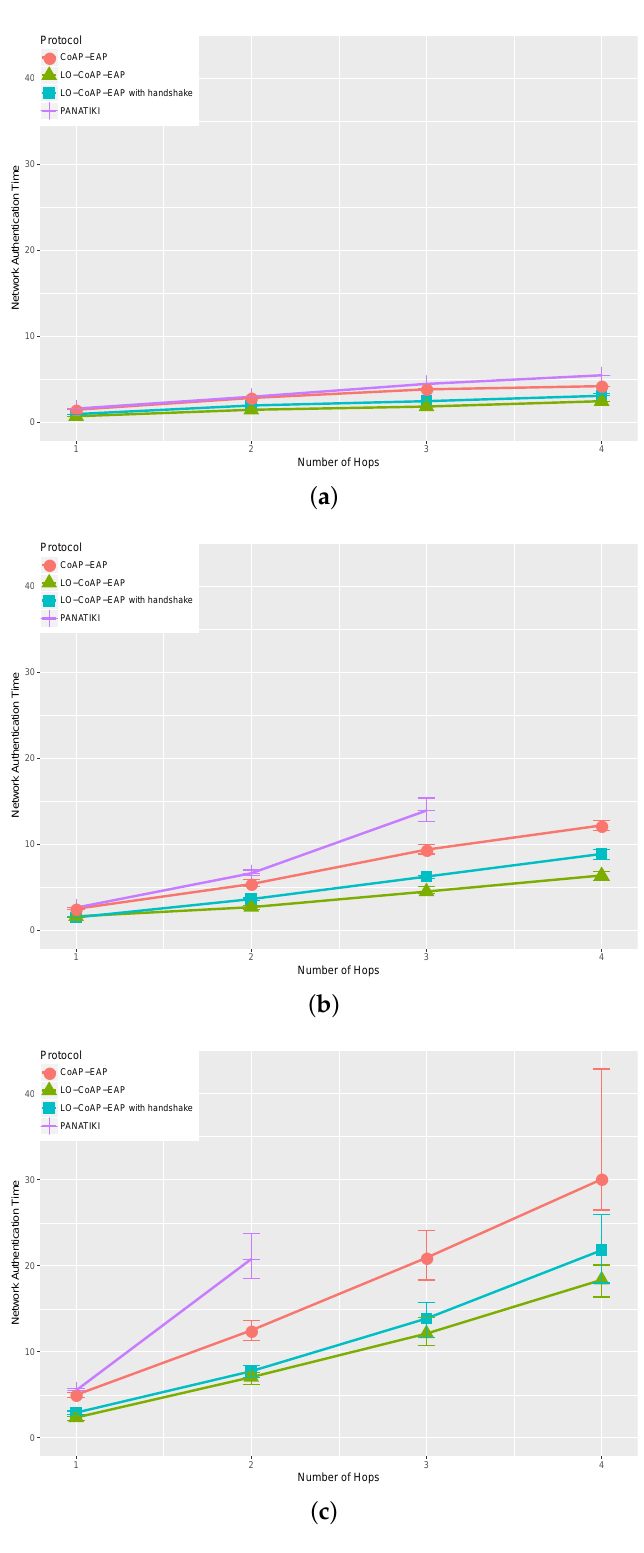
Figure 6. Median network authentication time in Cooja for LO-CoAP-EAP, CoAP-EAP and PANATIKI. ( a ) Median network authentication time with 0.0 loss ratio; ( b ) median network authentication time with 0.1 loss ratio; ( c ) median network authentication time with 0.2 loss